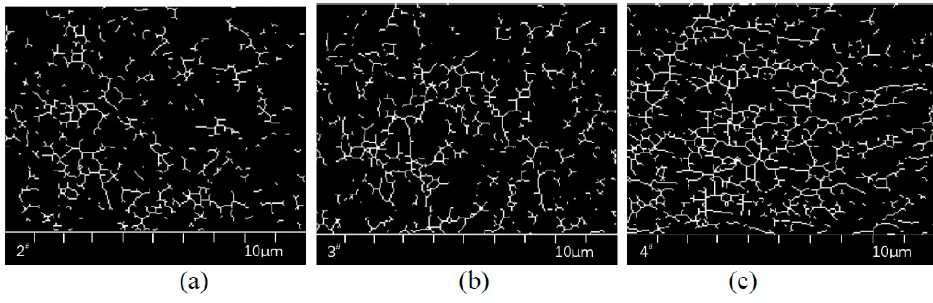
Figure 7. Cont. Figure 7. Cont